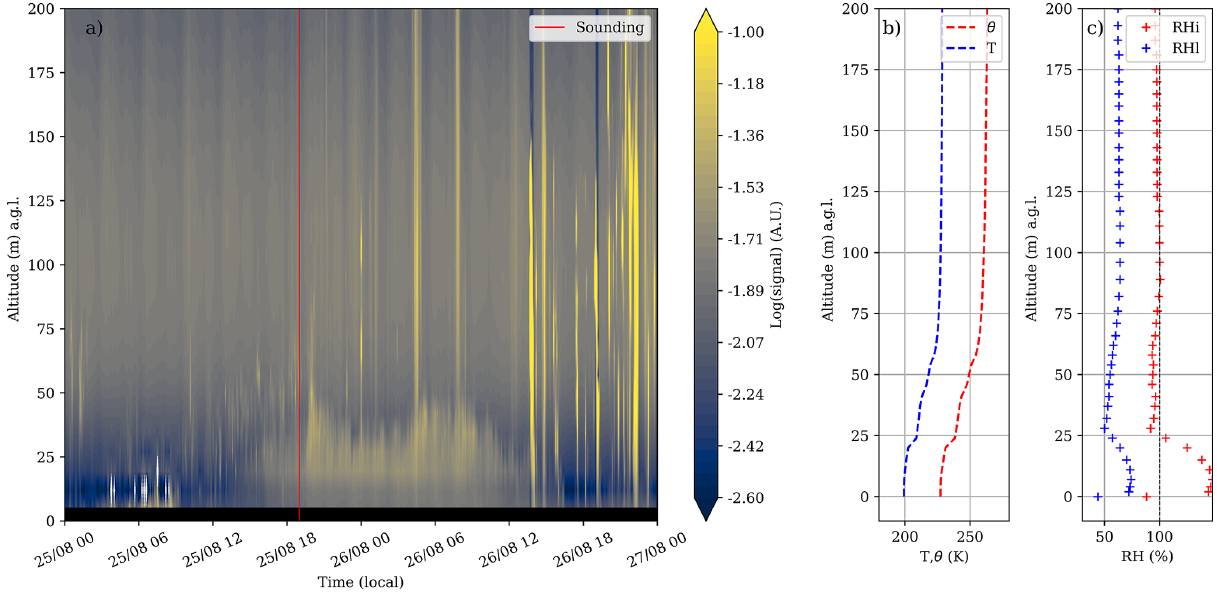
Figure 6. Same as Fig. 2 but for Event 2.